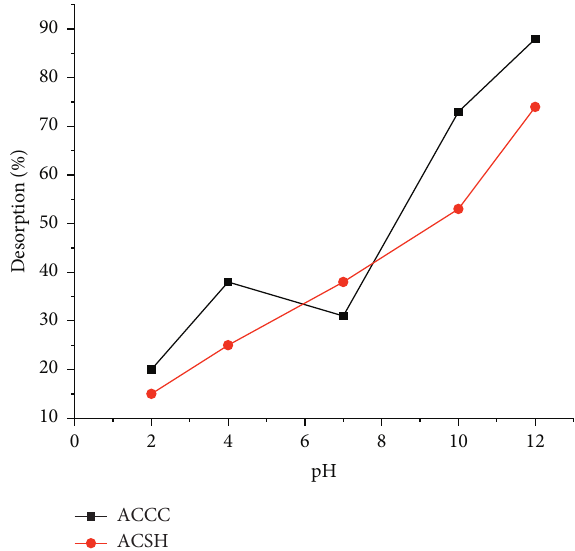
Figure 13: Regeneration of activated carbon of corncob (ACCC) and sorghum husk (ACSH) at different pH. Table 3: Fluoride removal from the real water samples using the adsorbents prepared from corncob and sorghum husk at optimized